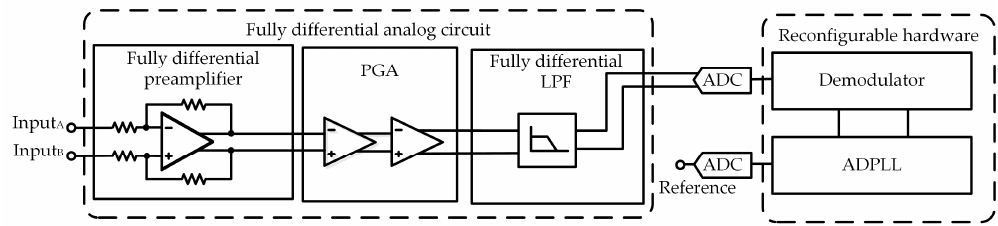
Figure 1. Architecture of the digital lock-in amplifier (DLIA) with two major parts: one is the fully differential analog circuit and the other is the reconfigurable hardware. (PGA is programmable gain amplifier, LPF is low-pass filter, ADC is analog-to-digital converter, ADPLL is all-digital phase lock loop.)